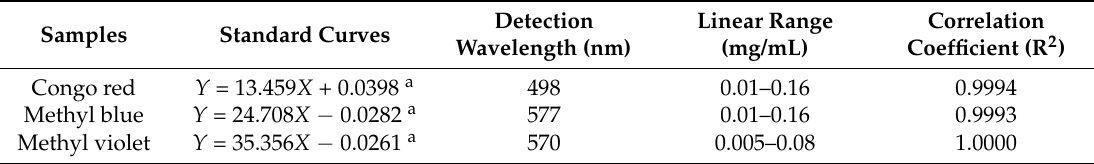
Table 1. The detection conditions and standard curves for analysis of